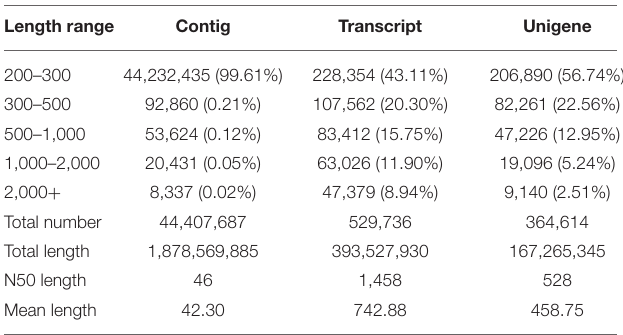
TABLE 2 | Overview of de novo sequencing and assembly.